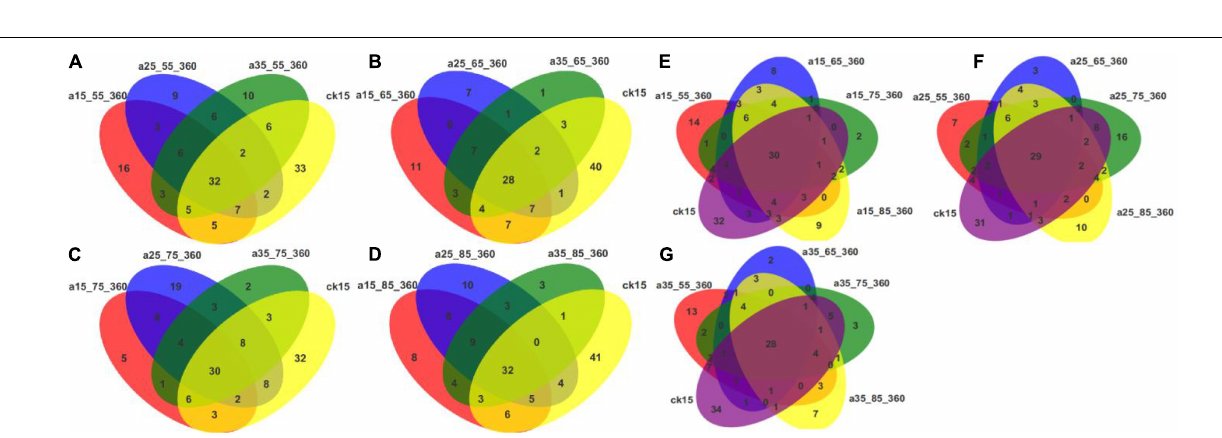
Frontiers in Microbiology |